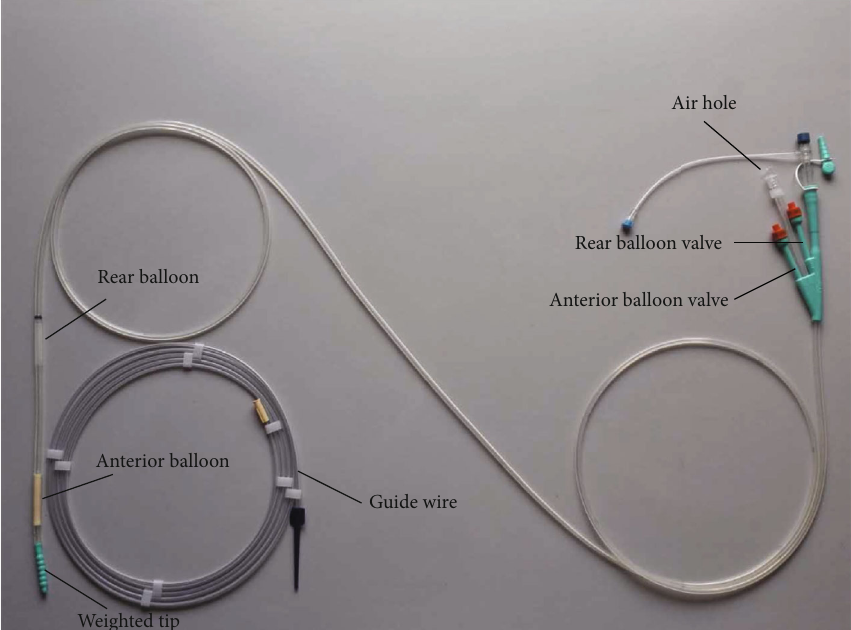
Figure 1: The schematic diagram of the CLINY Ileus Tube suite (Create Medic, Tokyo, Japan). The tube is 300cm in length, 16Fr or 18Fr. The front of the tube is composed with a weighted tip, anterior balloon, and rear balloon. At the end of the tube, there is an anterior balloon valve (marked F. BALL), an air hole (marked VENT), and a rear balloon valve (marked B.